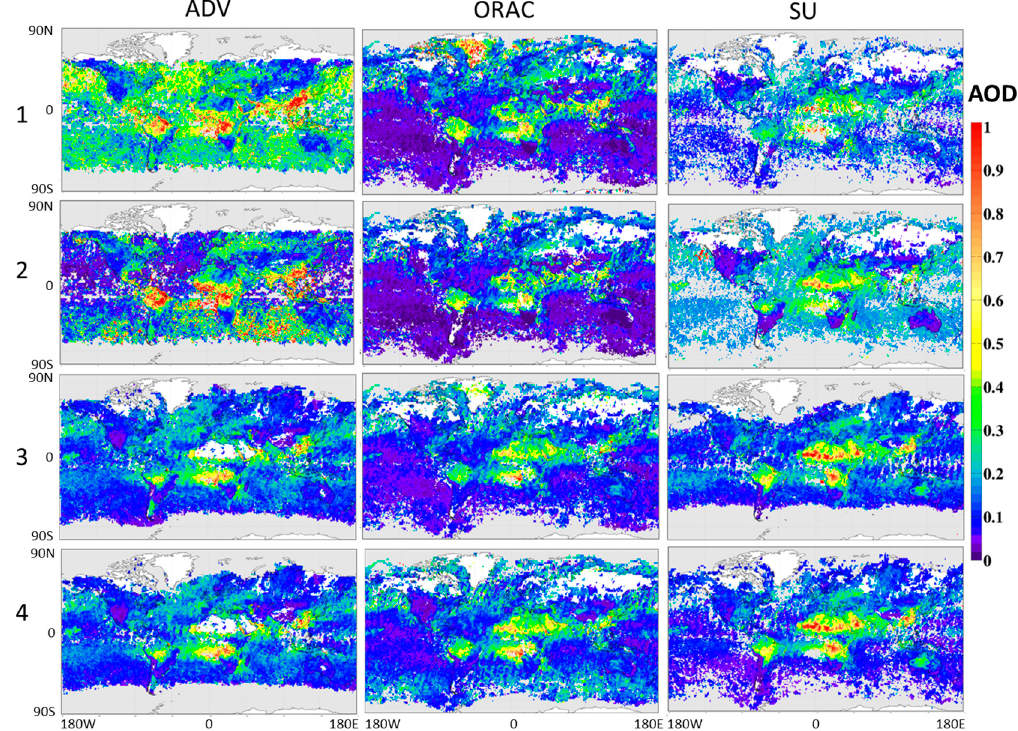
Figure 3. Monthly mean AOD for September 2008 from 3 algorithms (3 columns) for 4 stages (4 lines, 1: algorithm experiments; 2: round robin exercise; 3: one-year data processing; 4: 17 year data processing) of the development cycle.